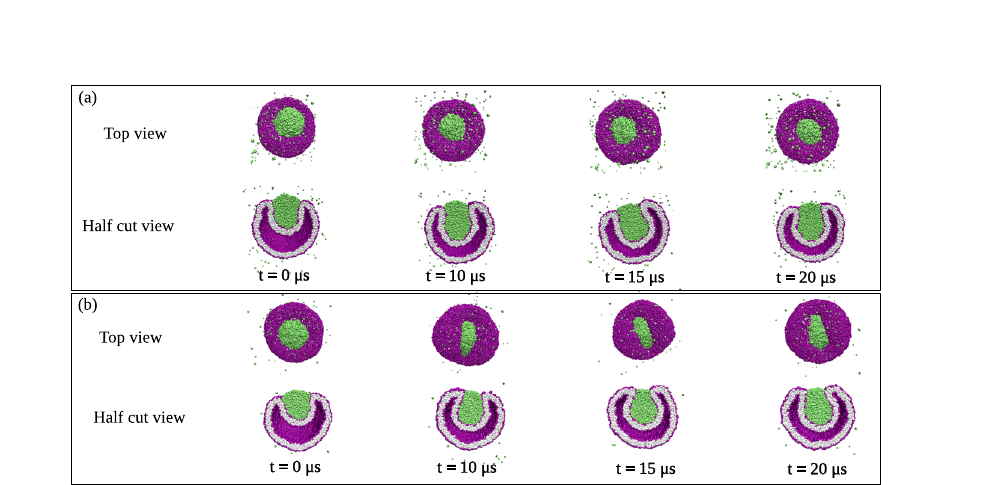
Fig. 4 | Complete nonaxisymmetric engulfment of nanodroplets (green) with- outdivisionofnanovesicle(purple – gray).a Nanovesicleformedbyalipidbilayer with N ol =5700 lipids in the outer and N il =4400 lipids in the inner lea fl et. At time t =0, we start with vesicle volume ν =0.7, for which we observe an axisymmetric morphology of vesicle and partially engulfed droplet (green) that persists until t =12 μ s, see white dashed circles around the contact lines. At t =12 μ s, we reduce the vesicle volume from ν =0.7 to ν =0.6, which leads to complete engulfment of the droplet and to a nonaxisymmetric morphology of the vesicle – droplet couple. The broken rotational symmetry is directly visible from the strongly noncircular and highly elongated contact line, see white dashedrectangles around the contact